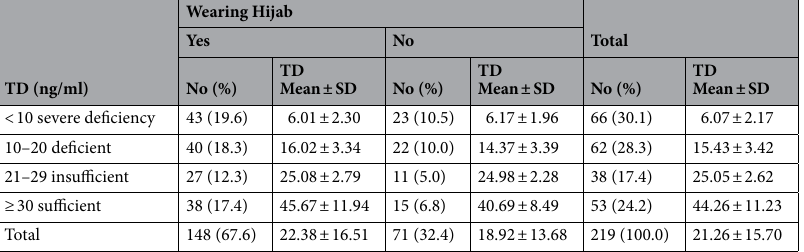
Table 8. Mean and standard deviation of Total 25-OHD level in respect to dress style. P-value = 0.786.